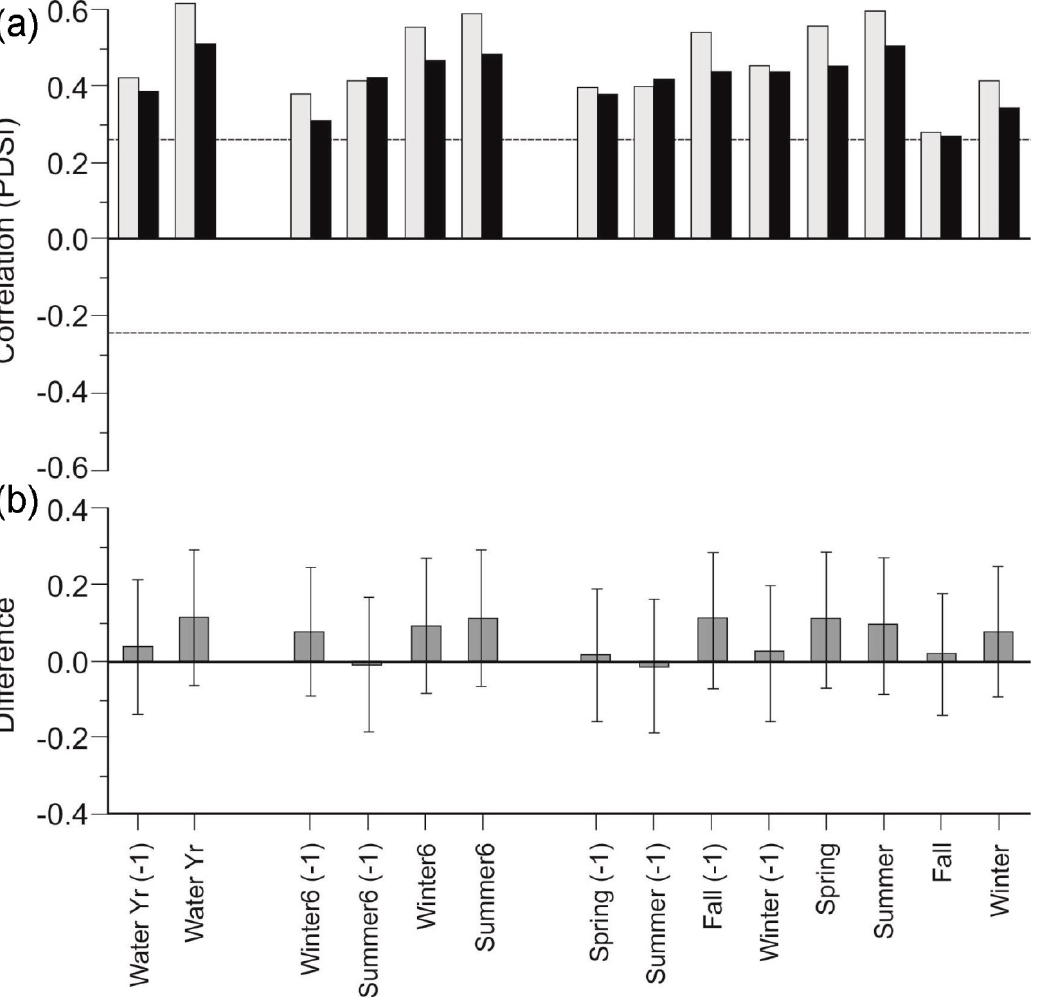
Figure 7. ( a ) Correlations between radial growth index of Douglas-fir growing among conspecifics (light gray) and heterospecifics (solid) and seasonal values of the PDSI (see text for time windows). Significance levels and confidence limits are indicated as in Figure 2. ( b ) Growth–climate response differences for the two chronologies. Positive values indicate that Douglas-fir growing among conspecifics are more positively correlated to the PDSI than Douglas-fir growing among heterospecifics during that season. The error bars indicate the 95% confidence limit on the difference.